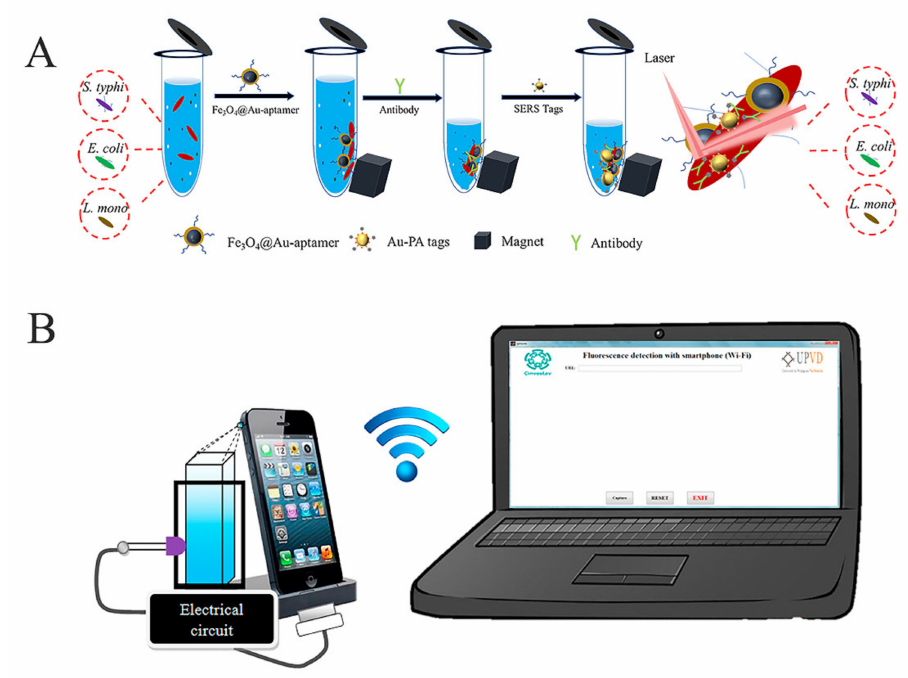
Figure 4. ( A ) Enhancement of specific and sensitive sensing of Salmonella by the pretreatment of magnetic separation and enrichment [72]. ( B ) Fluorescence detection strategy based on a smart- phone